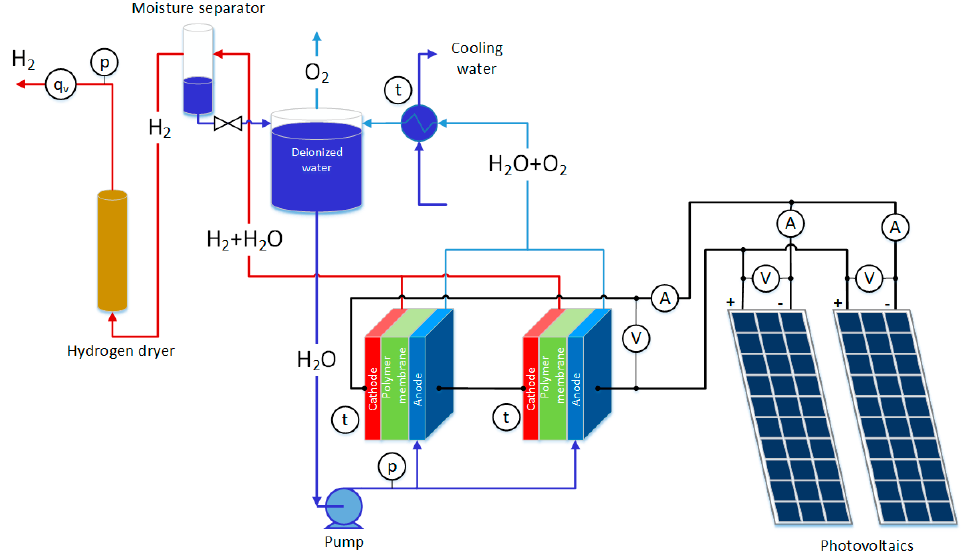
Figure 2. Scheme of the electrolyzers supplied with electricity from photovoltaic (PV) panels.